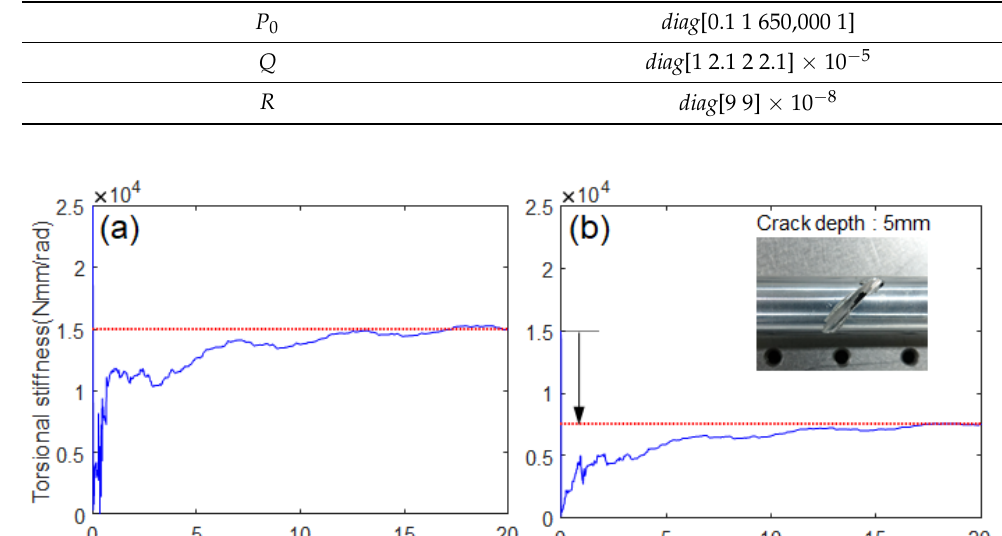
Figure 12. Experimental results for different crack scenario: ( a ) without crack, ( b ) with crack (crack depth: 11 mm) [Supplementary Materials].